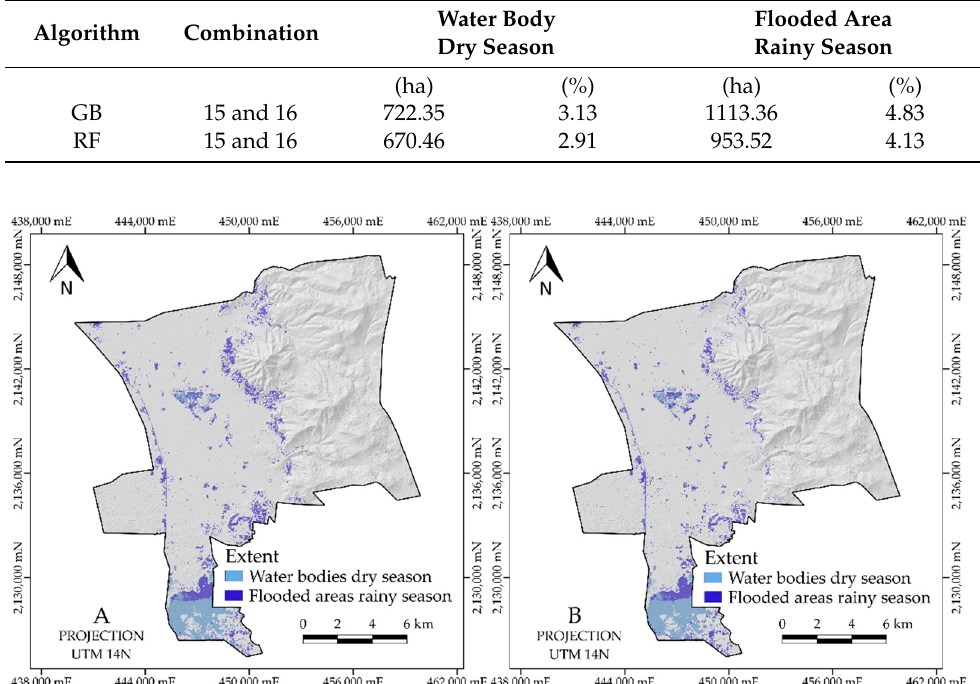
Figure 8. Extent of water bodies in the dry season and flooded areas in the rainy season calculated from the spatial and temporal analysis of pixels with gradient boosting ( A ) and random forest ( B ) algorithms.